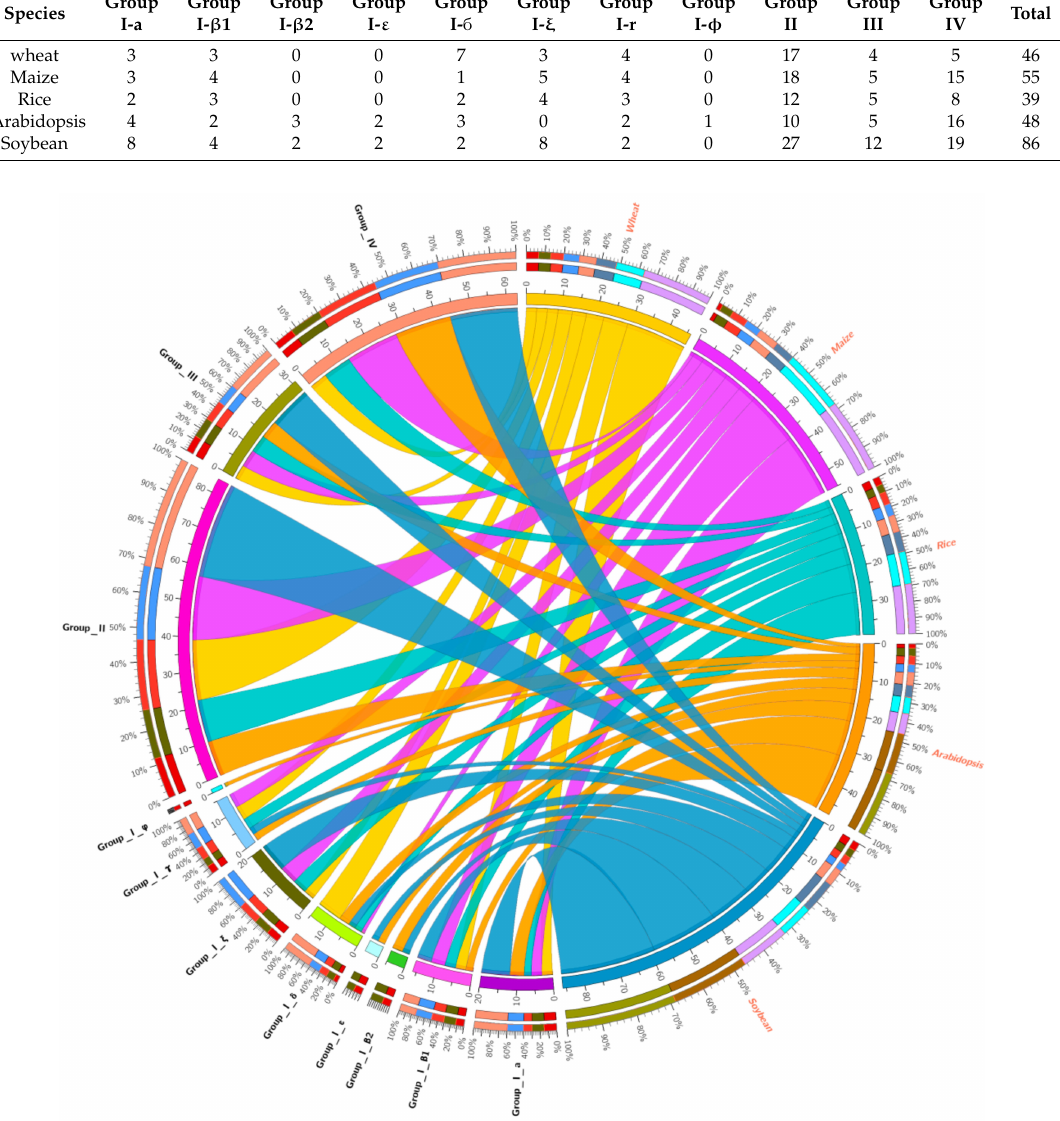
Figure 3. The distribution of HD-Zip transcription factors from wheat, maize, Arabidopsis , rice and